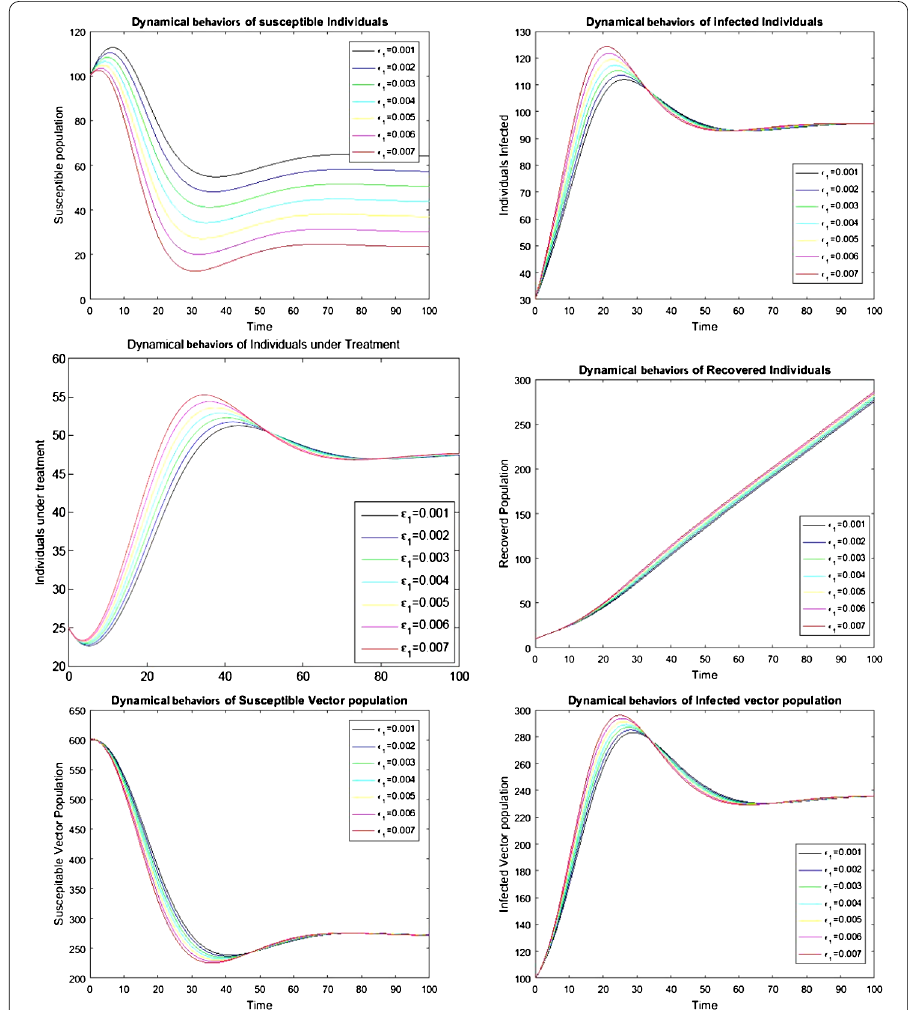
Figure 6 The plots show the dynamical behavior of population sizes with increasing vertical transmission rate